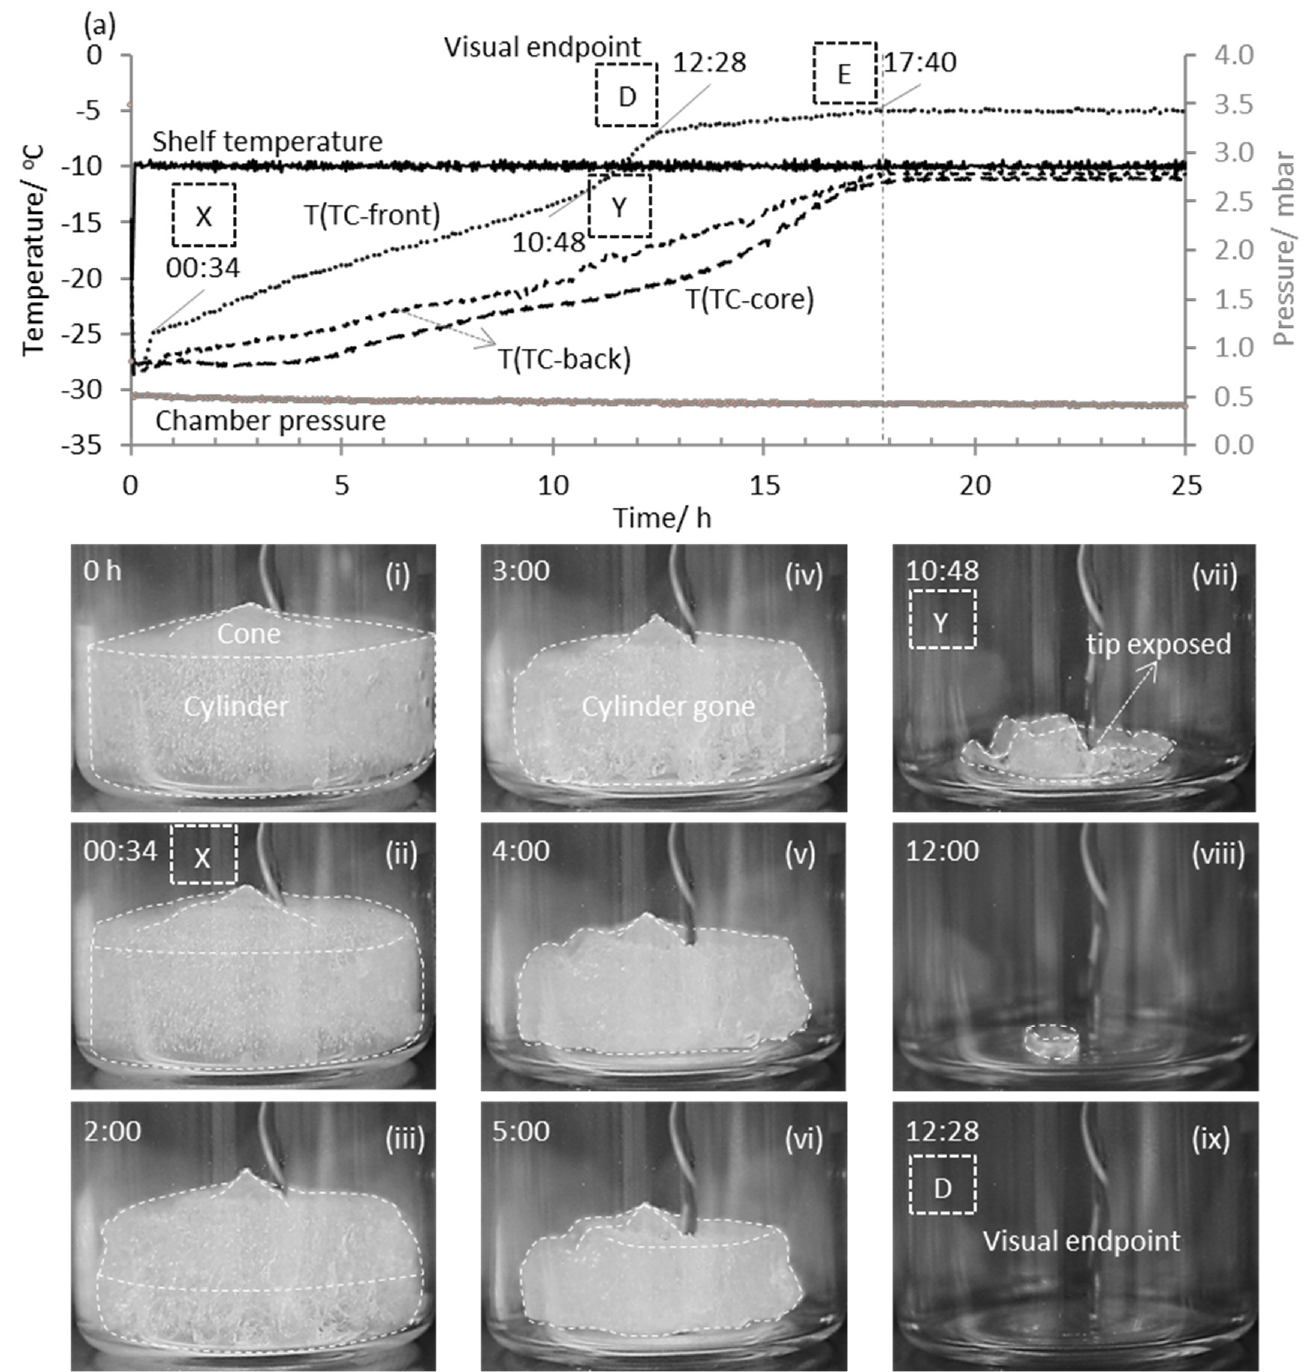
Figure 5. Determination of visual endpoint in the front edge vial containing a thermocouple and using this information to estimate the batch endpoint: ( a ) time-lines of the process parameters, namely the shelf temperature, the chamber pressure and the product temperature, T(TC-front), T(TC-back) and T(TC-core), at the bottom-center of the vial adjacent to each of the three TVIS vials located at the front edge of the shelf, the back edge of the shelf and in the core. Shown below this are photographs ( i – ix ) of the ice mass in the front TC vial taken at various time-points during primary drying. The labels X and Y enclosed by the dashed lines correspond to the inflections that indicate the detachment of the sensor from the ice layer in the immediate vicinity. The inflection at D and E correspond to the visual endpoint and the point at which all measurement vials reach equilibrium respectively.